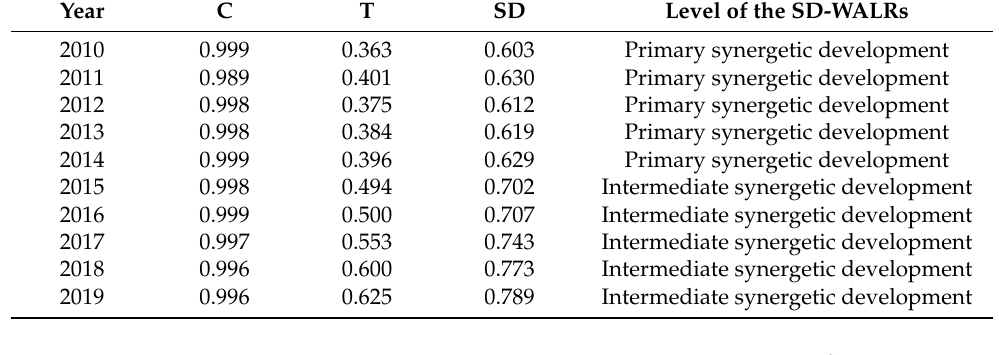
Table 6. Evaluation results of the SD of water and land resources.